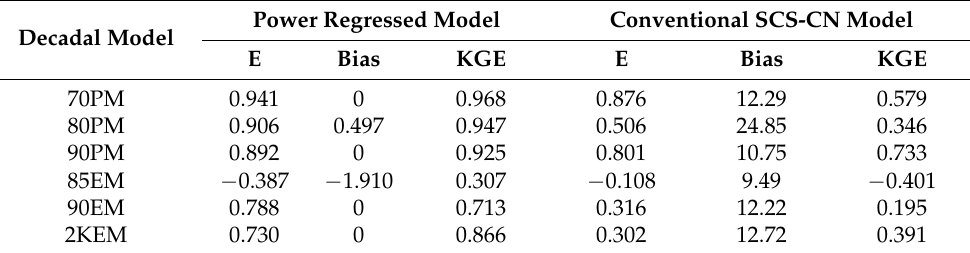
Table A1. Comparison of the performance of the recalibrated model with the conventional model, based on the Nash–Sutcliffe index (E), the bias, and the Kling–Gupta efficiency index (KGE) for each decadal model in Peninsular Malaysia and East Malaysia, with the constraint I a < P applied to the conventional SCS-CN model.